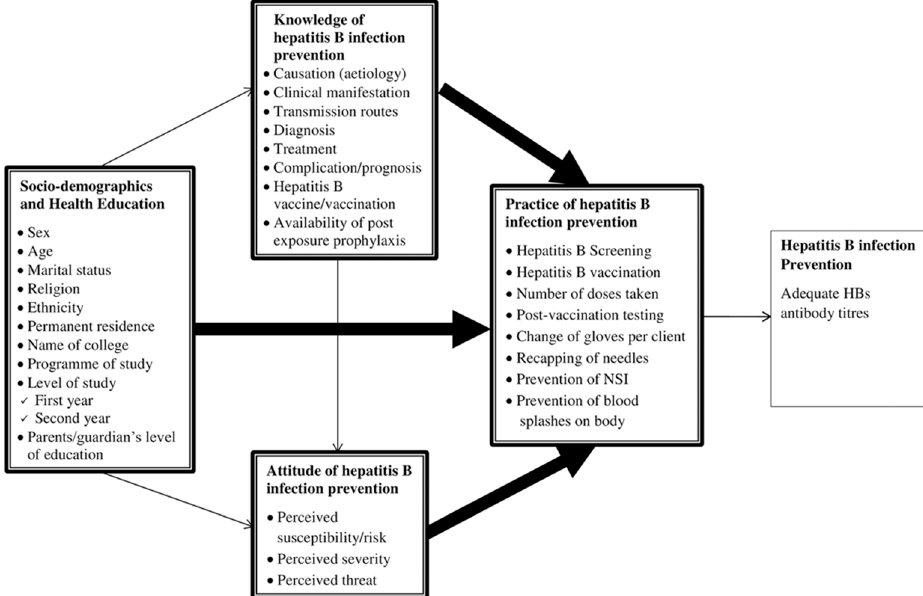
Figure 1. Reference model for looking at the relationship between Respondents’ Characteristics, Knowledge, Attitudes, and Practice of Hepatitis B infection prevention (Adapted with permission from: Balegha et al. [10]. PLoS ONE, Published by PLOS, 2021).